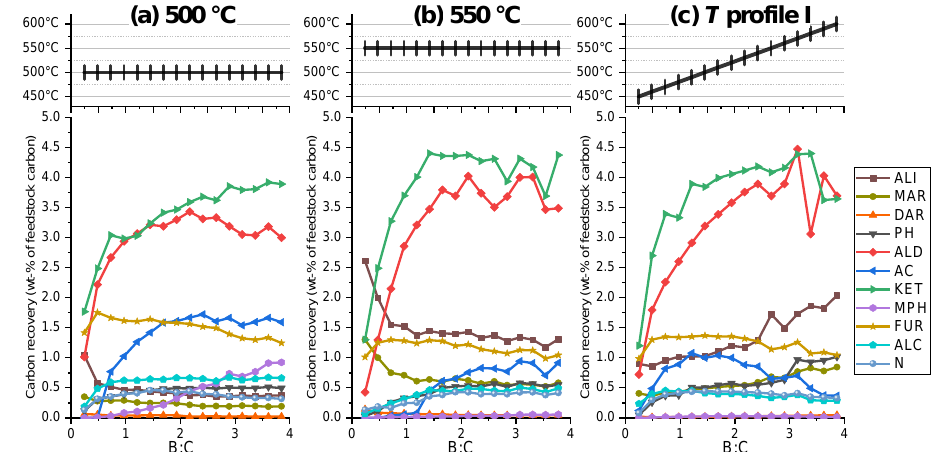
Figure 6. Carbon recovery of vapor products quantified by GC-FID when using γ-Al 2 O 3 as a catalyst at temperatures of ( a ) 500 °C, ( b ) 550 °C, and ( c ) following T -profile I. The momentary carbon yields per biomass injection are shown. Legend applies to all graphs.